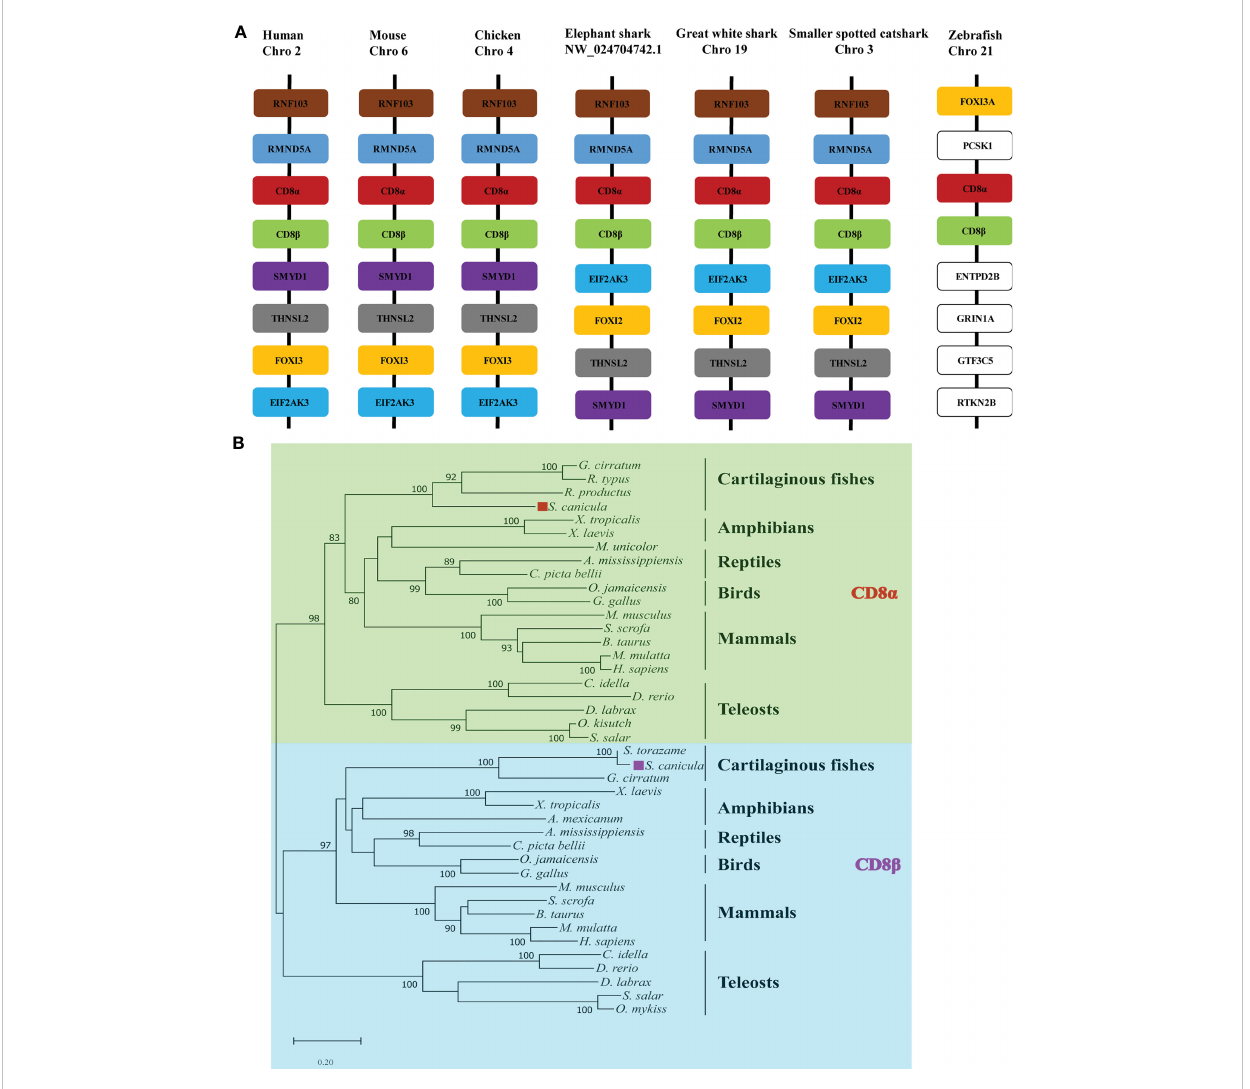
FIGURE 1 Analysis of ScCD8 genes. (A) Gene synteny analysis of CD8 a , the synteny information for human, mouse, chicken, elephant shark, great white shark, zebra fi sh and small-spotted catshark, and spotted gar genes were obtained from the Ensembl database. (B) Neighbor-joining (N-J) phylogenetic tree of CD8 genes. The tree was constructed using the N-J method within the MEGA-X program with bootstrap values shown next to the branches based on 10,000 bootstrap replications. “ ◼ ” indicates Sc CD8 a (red) and Sc CD8 b (purple). The accession numbers of protein sequences are provided in Supplementary Table